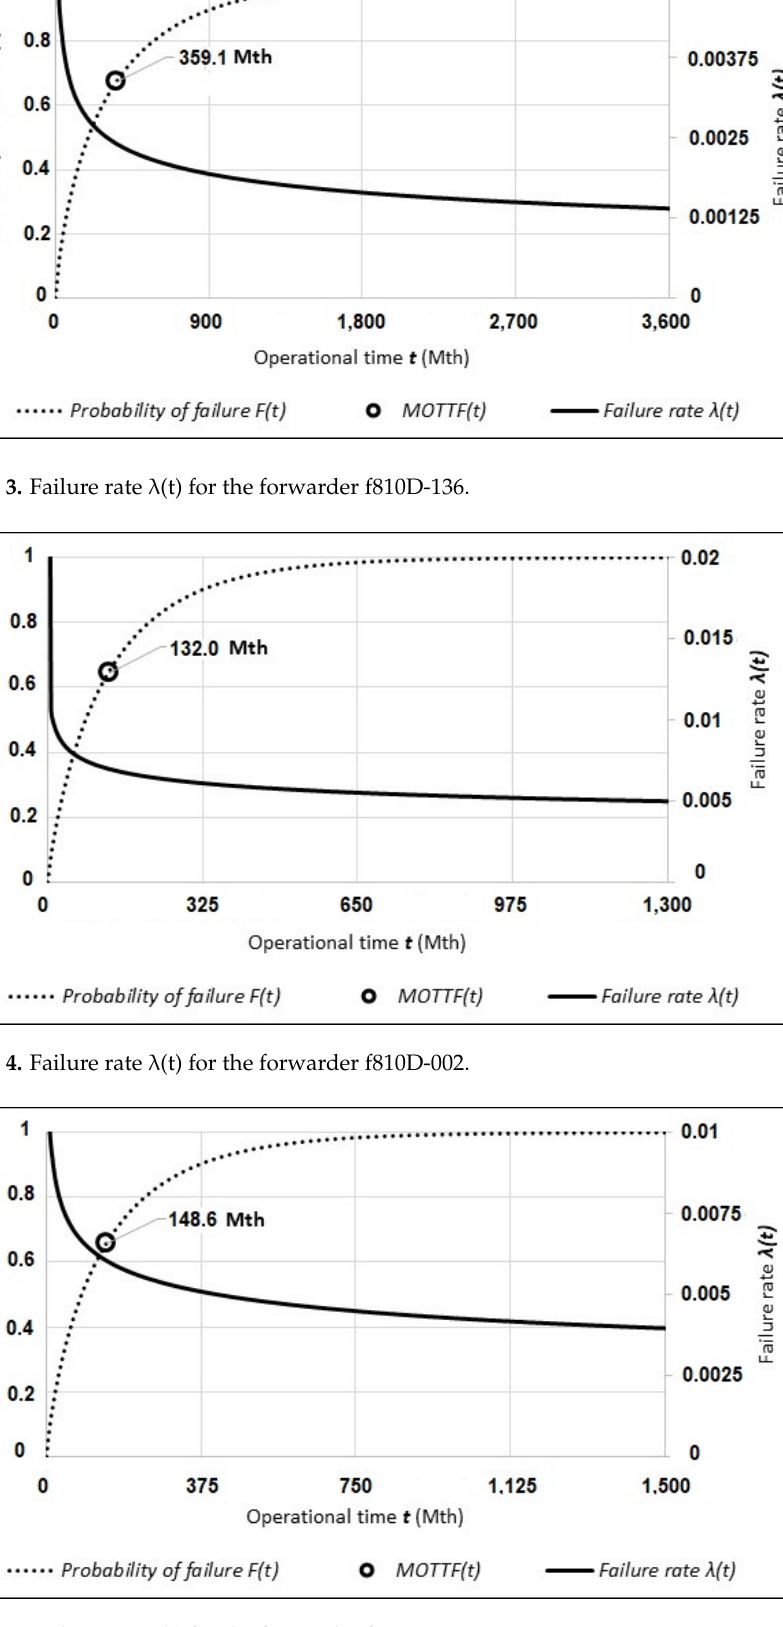
Figure 6 Failure rate λ (t) for the forwarder f810D-1110. As the last indicator of reliability, there was a defined MOTTF. For all the observed machines, Weibull distribution and prediction were used, obtaining: 𝑀𝑂𝑇𝑇𝐹 (cid:3404) 𝛼. Γ.(cid:3436)1 (cid:3397) 1 𝛽(cid:3440) ≅ 𝛼 (25) 𝑀𝑂𝑇𝑇𝐹 (cid:3404) 𝛽 ∙ Γ (cid:3436)1 (cid:3397) 1 𝛼(cid:3440) (26) where: α , β —are the parameters of Weibull distribution; Γ —gamma function (table value). Mean operating times to failure (MOTTFs) for the types of machines and individual forwarders are shown in Table 4.